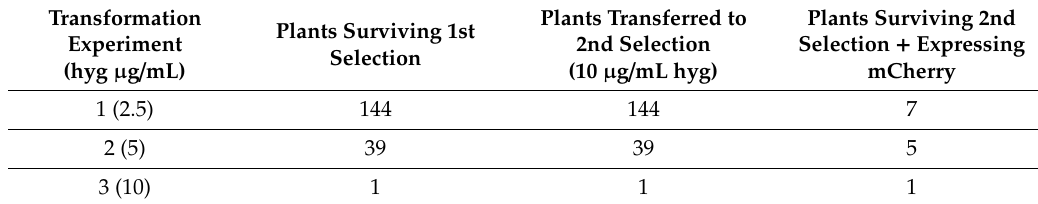
Table 1. R. fluitans 001TC transformation results. Three independent transformation experiments using the pro Mp EF1 α :: mCherry construct were successively subjected to two hygromycin selection steps with indicated concentrations. Together, 13 T1 lines survived the selection procedure and expressed mCherry fluorescence.